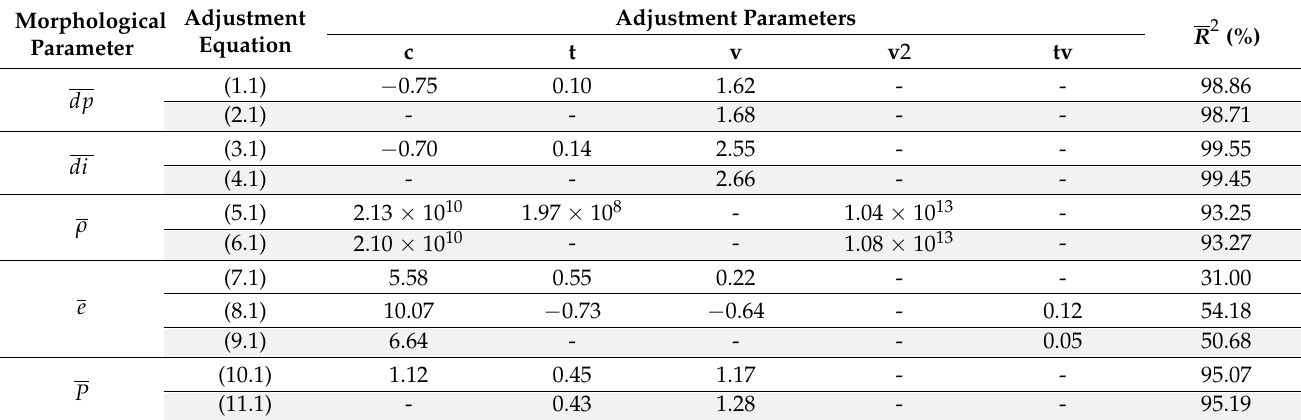
Table 3. Results of adjustments of the morphological parameters according to the synthesis variables. The selected adjustments are highlighted. Morphological